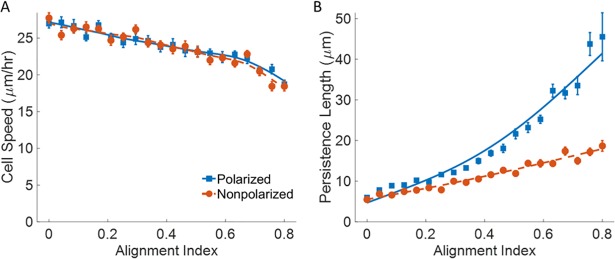
Effect of fiber alignment.Plots for vavg and Lp as a function of increasing alignment index A) Cell speed B) Persistence length. Cgel = 3.7 mg/ml, ρi = 6 sites/monomer, ρfiber = 1.0 x 10−3 fibers/μm3, and tsearch = 16s. Simulation time = 48hrs. n = 20. Solid blue lines are polarized cells (◼), dashed red lines are nonpolarized cells (●). Error bars represent ± SEM.